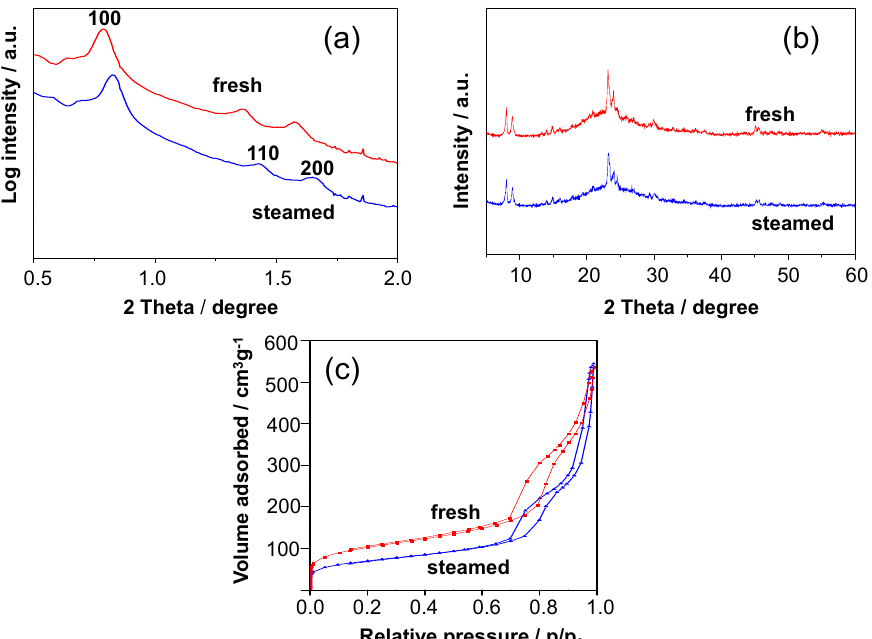
Figure 4. Effect of steaming of the ZSC composite at 800 °C for 24 h on the structural and textural properties: ( a ) Small ‐ angle X ‐ ray scattering (SAXS), ( b ) X ‐ ray diffraction (XRD) and ( c ) N 2 sorption isotherms [41]. This figure was published in J. Mater. Sci., Direct synthesis of